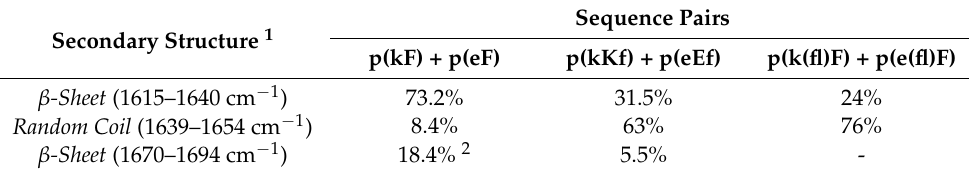
Table 2. Deconvolution analysis of FTIR spectra for sequence pairs. The curve fitting procedure is applied using Origin software. The area under the curves is measured with the Gauss function. Each secondary structure percentage is calculated by dividing the area of its assigned peak by the total area in the 1610–1700 cm − 1 range. Peaks center around 1610, 1625, 1645, and 1680 cm − 1 are considered in the secondary structure analysis.